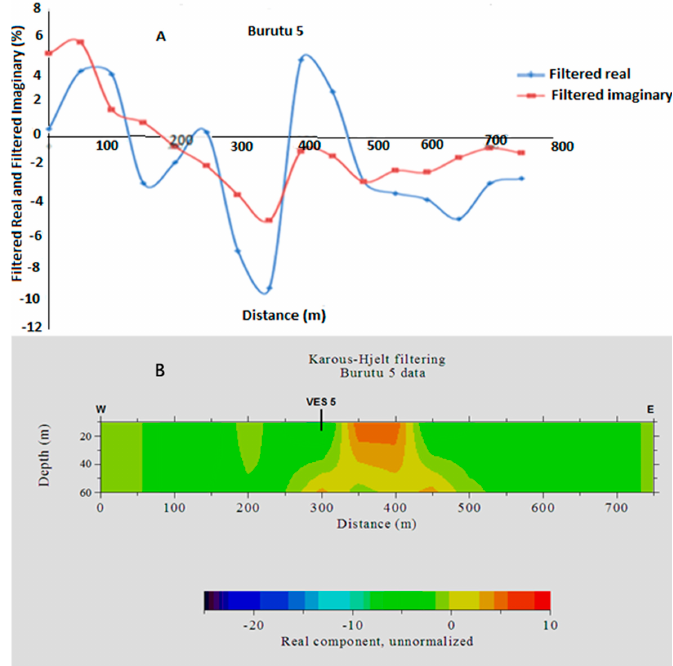
Figure 6. Plot of filtered Real and Imaginary components ( A ) and current density pseudo-section ( B ) for VLF Profile